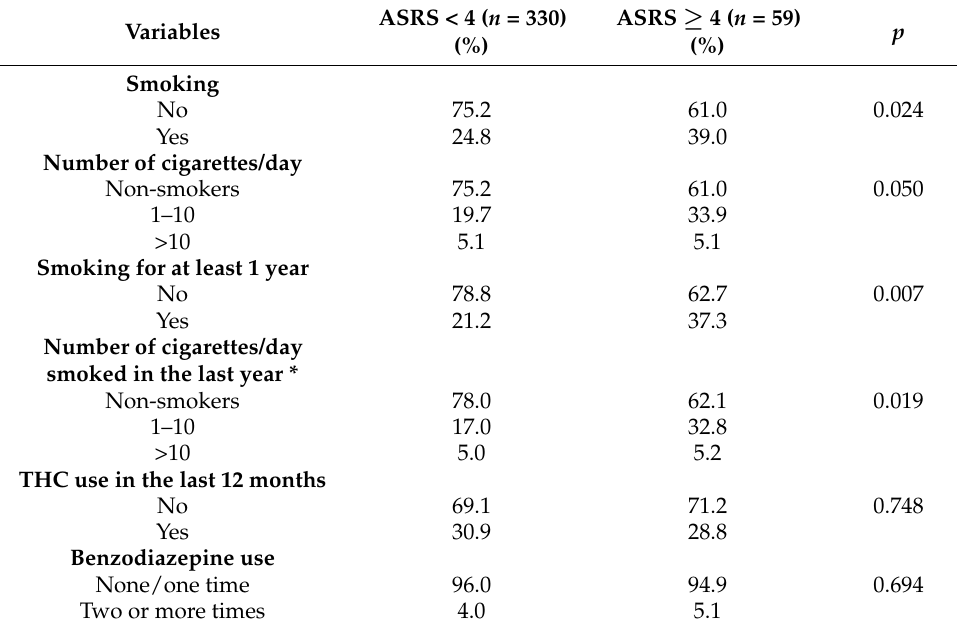
Table 3. Habits of subjects divided by positive ASRS questionnaire